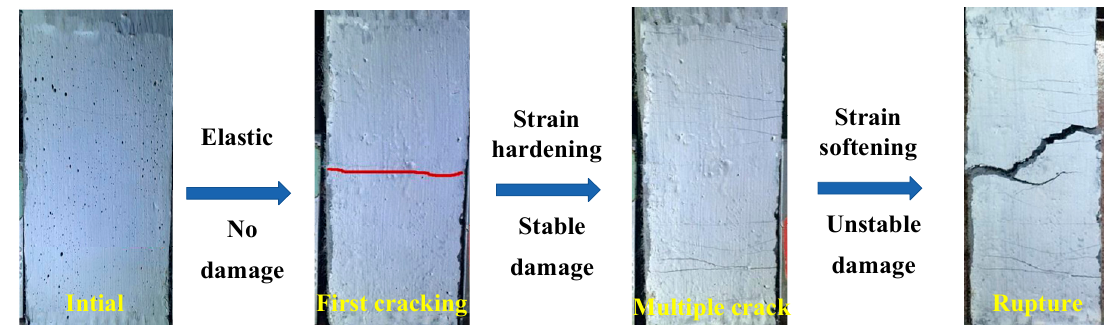
Figure 4. The crack pattern and damage evolution process of the specimens under uniaxial tension.